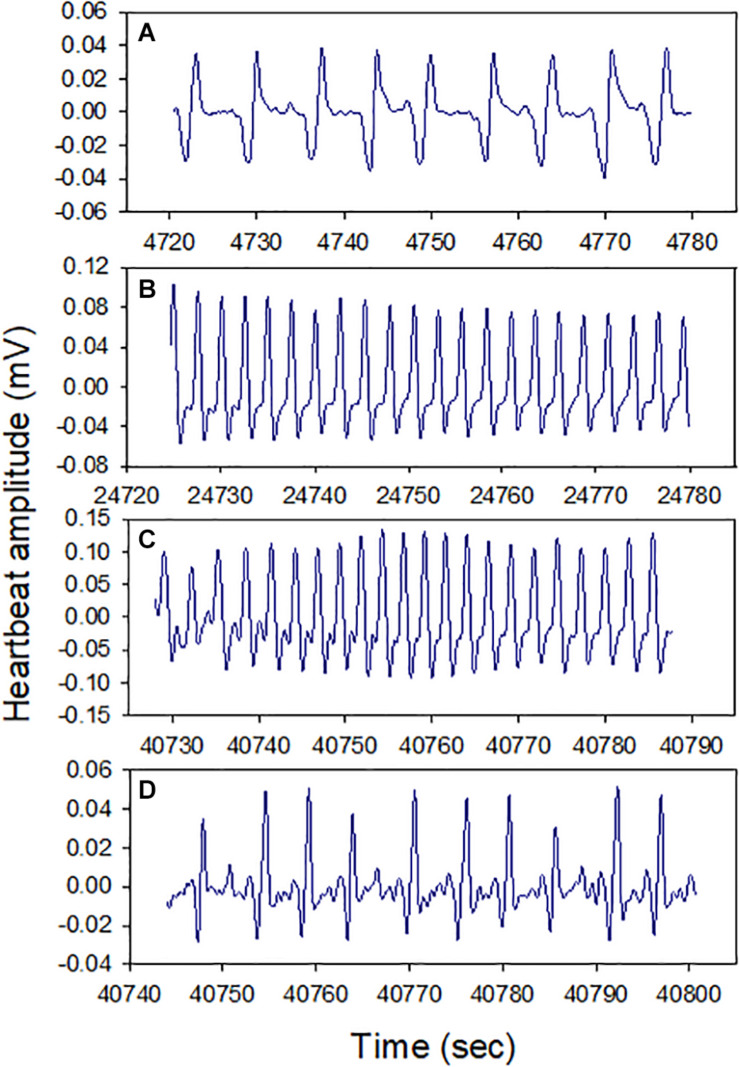
Cardiograms of snails at different times during 16 h air exposure (Letters A–D refer to points indicated in Figure 2). Heartbeat rhythmicity (beat to beat periodicity) was maintained throughout this exposure period in all snails.